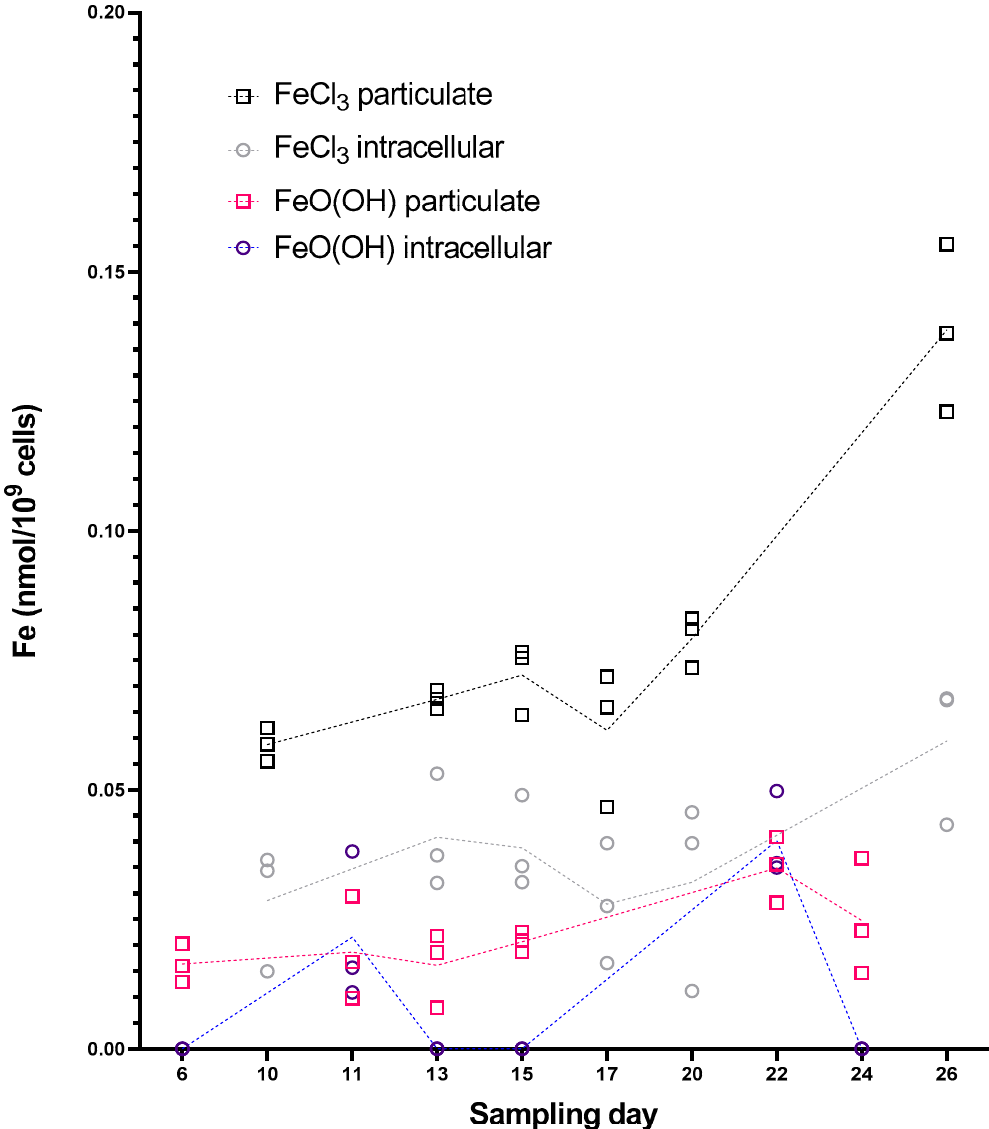
Figure 4. Particulate (PFe) and intracellular iron (InFe) concentrations in nmol Fe per 10 9 cells for cultures of Synechococcus grown on FeCl 3 and FeO(OH) in triplicate with added trend lines. Intracellular iron concentrations were obtained using an oxalate wash. Concentration per 10 9 cells values were obtained by dividing the total measured iron concentration by measured number of 10 9 cells per L sample (data obtained from optical density at 730 nm (OD 730 )).